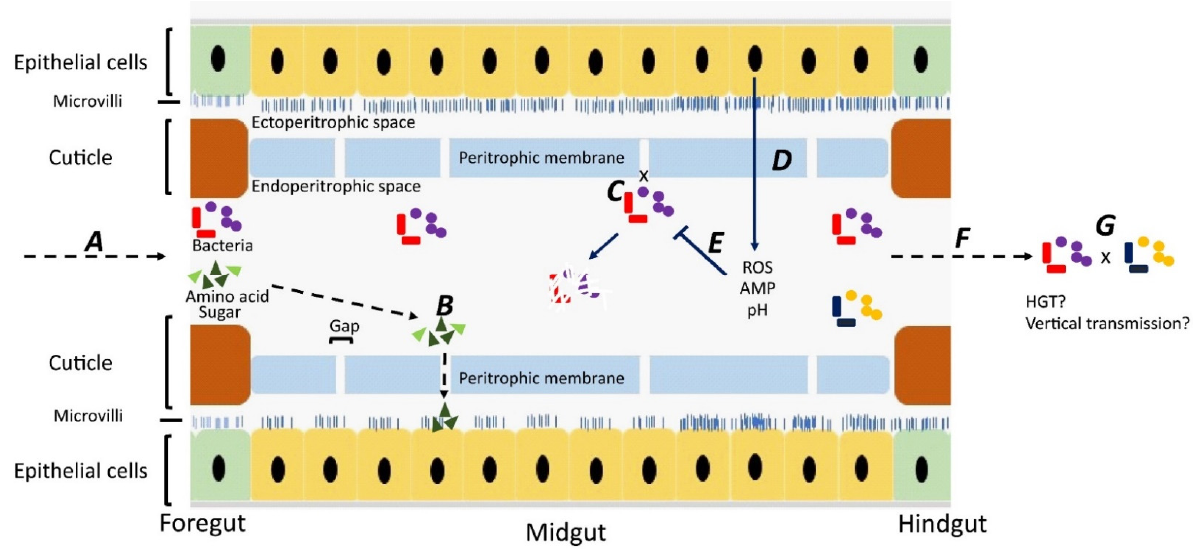
Figure 1. Fate of bacteria in the digestive tract (midgut) of flies. A: Ingested food with bacteria is predigested with saliva in the crop. The epithelial cells in the foregut are covered by a cuticle, which prevents bacterial invasion. B: In the midgut, digestion products can pass through gaps in the peri- trophic membrane and enter the ectoperitrophic space to be absorbed by epithelial cells. C: Bacteria cannot pass through the gaps on the peritrophic membrane and remain in the endoperitrophic space. D: Bacteria are trapped in the endoperitrophic space, triggering an innate immune response in epithelial cells to produce reactive oxygen species (ROS) and antimicrobial peptides (AMP). E: Trapped bacteria are killed by ROS, AMP, pH changes, and digestive enzymes. F: Some bacteria survive in the hostile environment, pass through to the hindgut, and are shed. G: There might be horizontal gene transfer between bacteria surviving in the digestive tract and bacteria may be trans- mitted vertically to offspring.